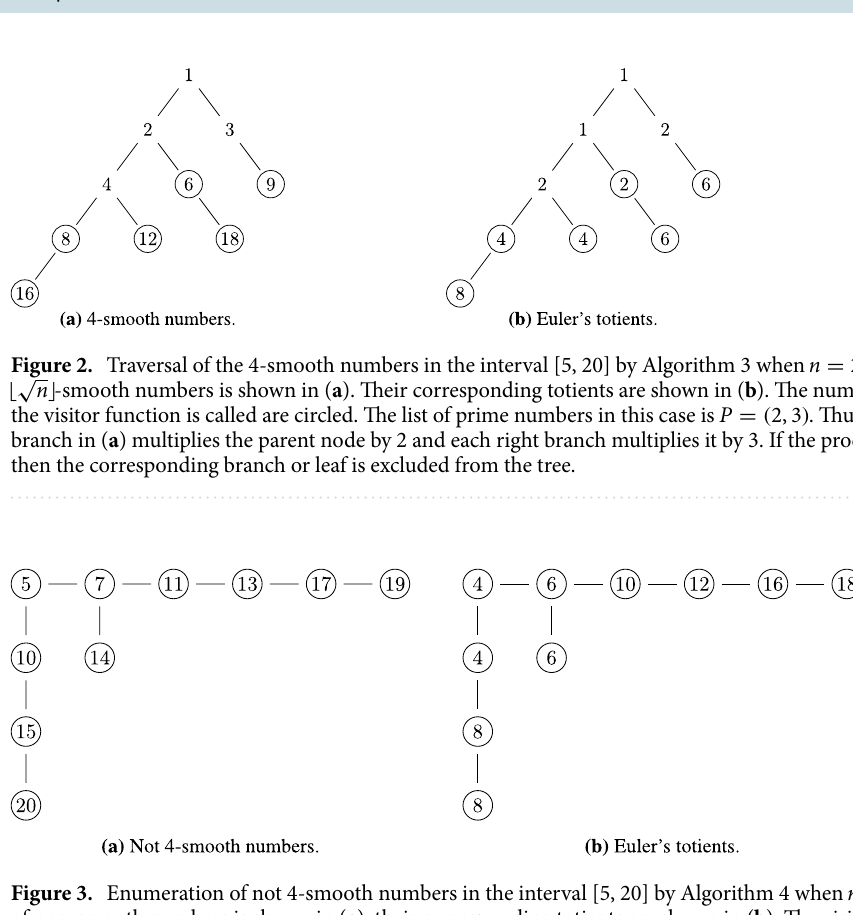
Figure 3. Enumeration of not 4-smooth numbers in the interval [5, 20] by Algorithm 4 when n of non-smooth numbers is shown in ( a ), their corresponding totients are shown in ( b ). The visitor function is called for all circled numbers.